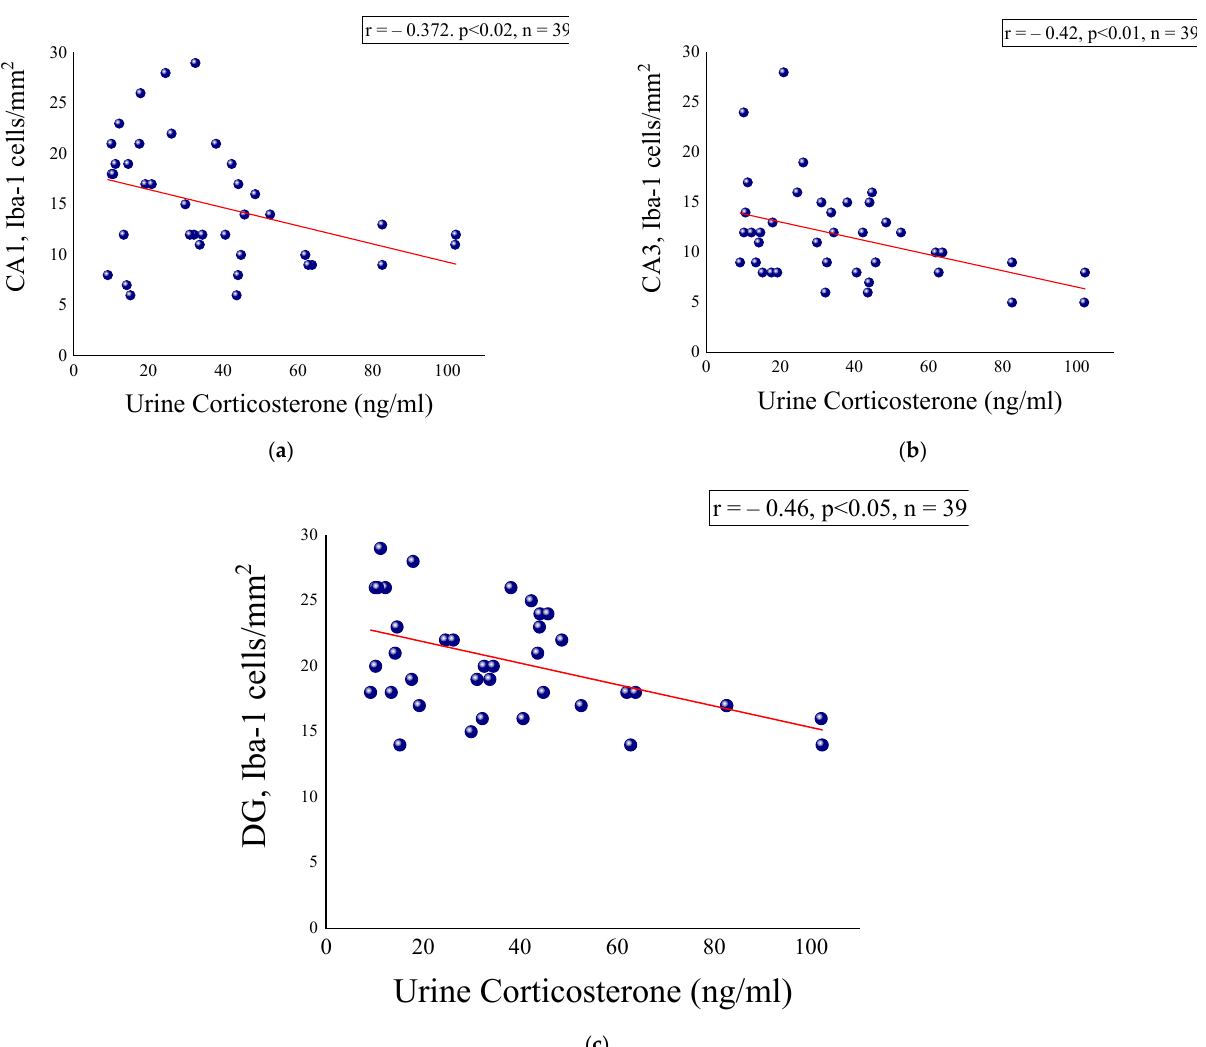
Figure 6. Correlation analysis between hippocampal microglia measures and urine corticosterone levels. ( a ) CA1 hippocampal subregion and urine corticosterone, ( b ) CA3 hippocampal subregion and urine corticosterone and ( c ) DG hippocampal subregion and urine corticosterone.